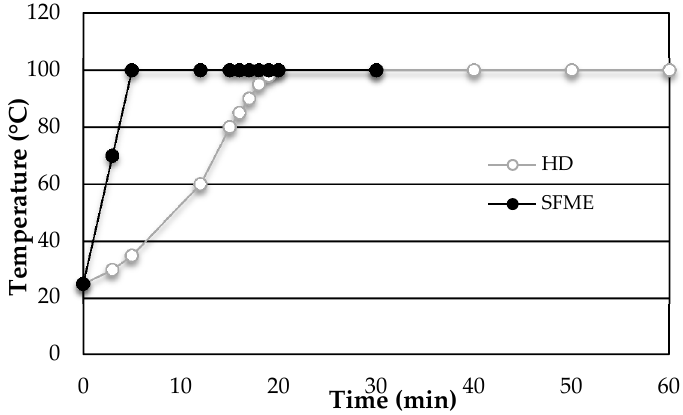
Figure 1. Temperature profiles as a function of time for the SFME ( ● ) and HD ( ○ ) extraction of EO from sweet basil leaves.